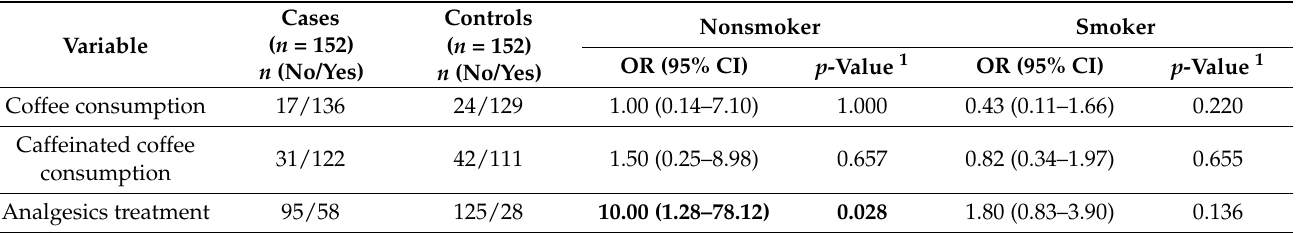
Table 3. Estimated odds ratios for coffee and analgesics consumption as risk factors for bladder cancer, stratified by smoking status.